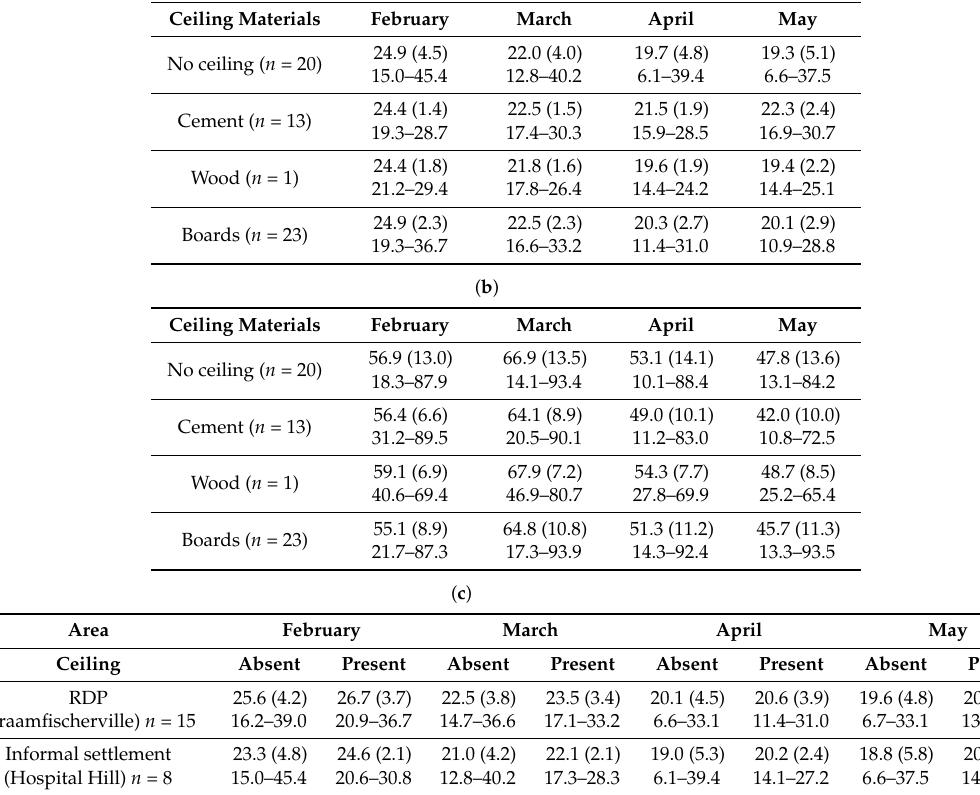
Table 8. ( a ) Monthly indoor temperatures (in ◦ C) by ceiling material (means and standard deviations, ranges below); ( b ) Monthly indoor humidity (%) by ceiling material (means and standard deviations, ranges below); ( c ) Comparison of indoor temperatures ( ◦ C) between dwellings with and without ceilings (means with standard deviations, ranges